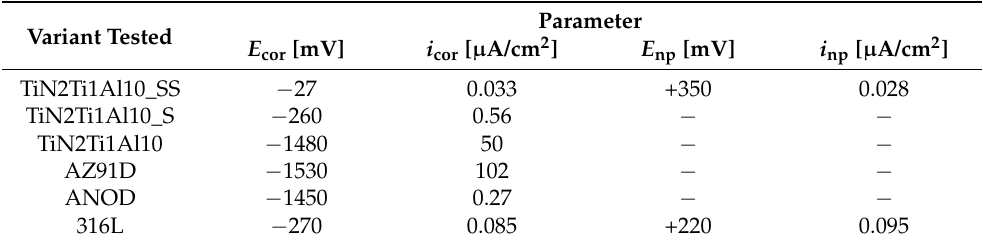
Table 4. Values of corrosion parameters in potentiodynamic tests (Figure 6): corrosion potential, E cor ; current density— I cor ; breakdown potential— E np ; current density— I np